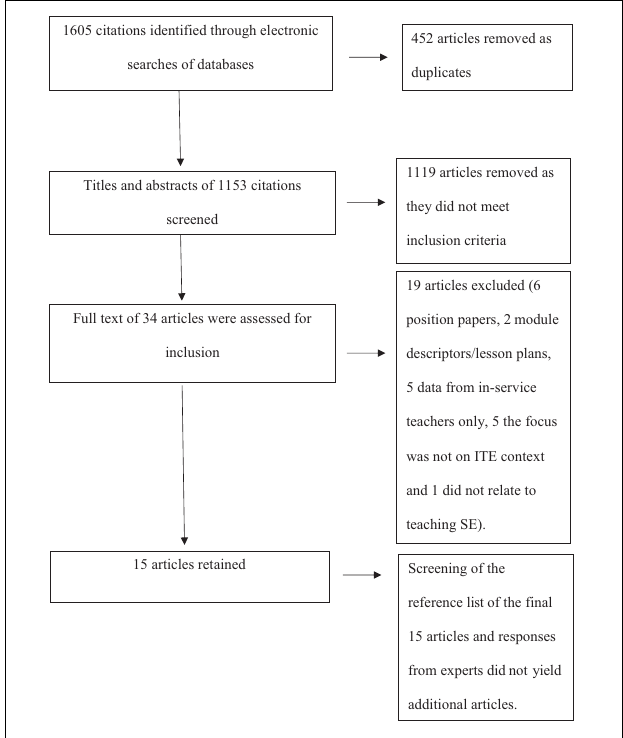
FIGURE 1 | Flow diagram of systematic review